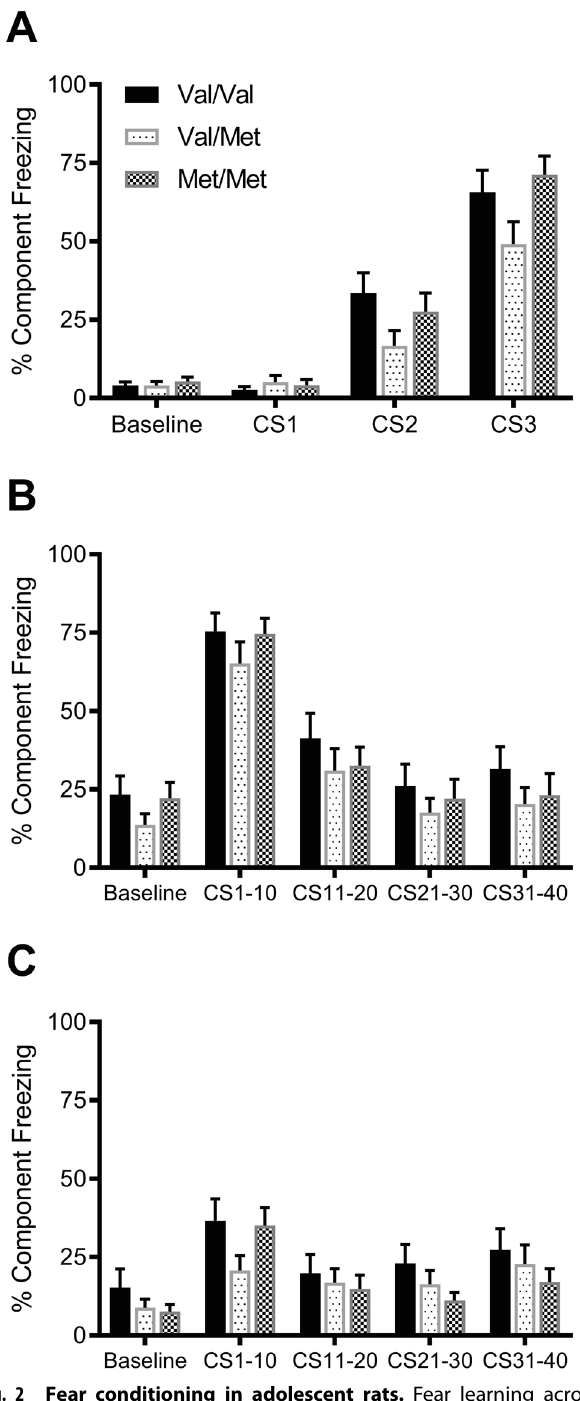
Fig. 2 Fear conditioning in adolescent rats. Fear learning across three CS tone periods on Day 1 ( A ), fear memory and extinction learning on Day 2 ( B ) and extinction memory on Day 3 ( C ). There were no signi fi cant differences between genotypes at any stage of testing in adolescent rats. Data presented as mean ± SEM. Individual data points for select periods can be found in supplementary Fig. 5. All data are presented as sexes